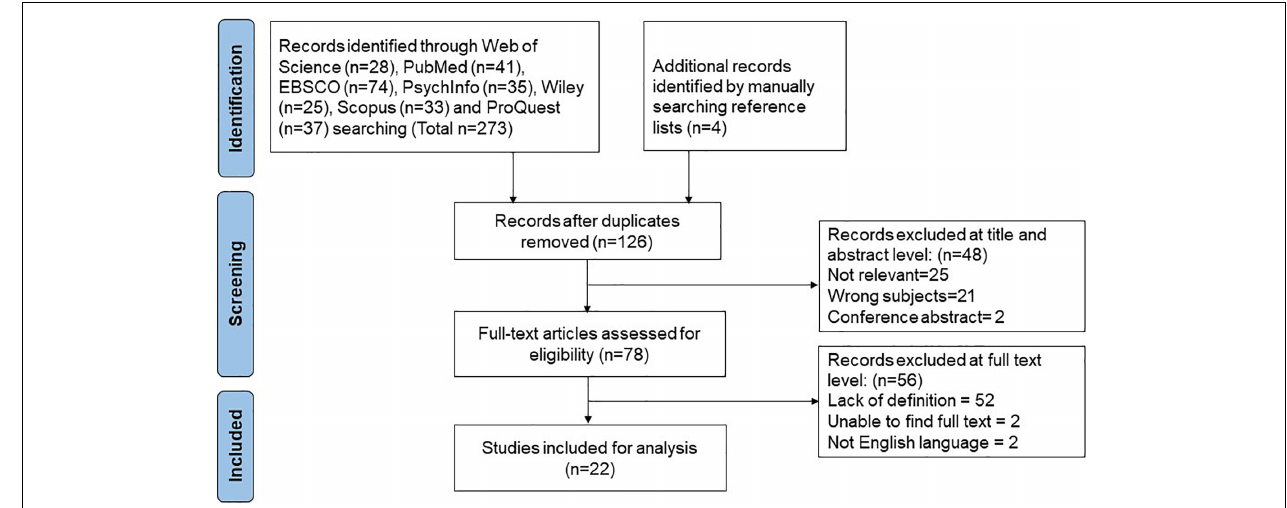
FIGURE 1 | Flow chart of study selection